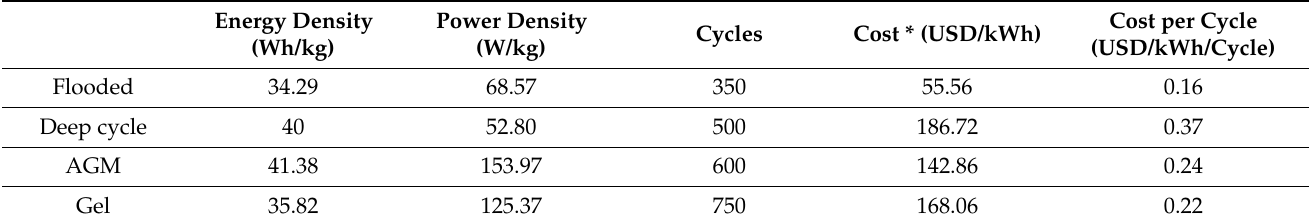
Table 2. Lead acid battery technology comparison, adapted from